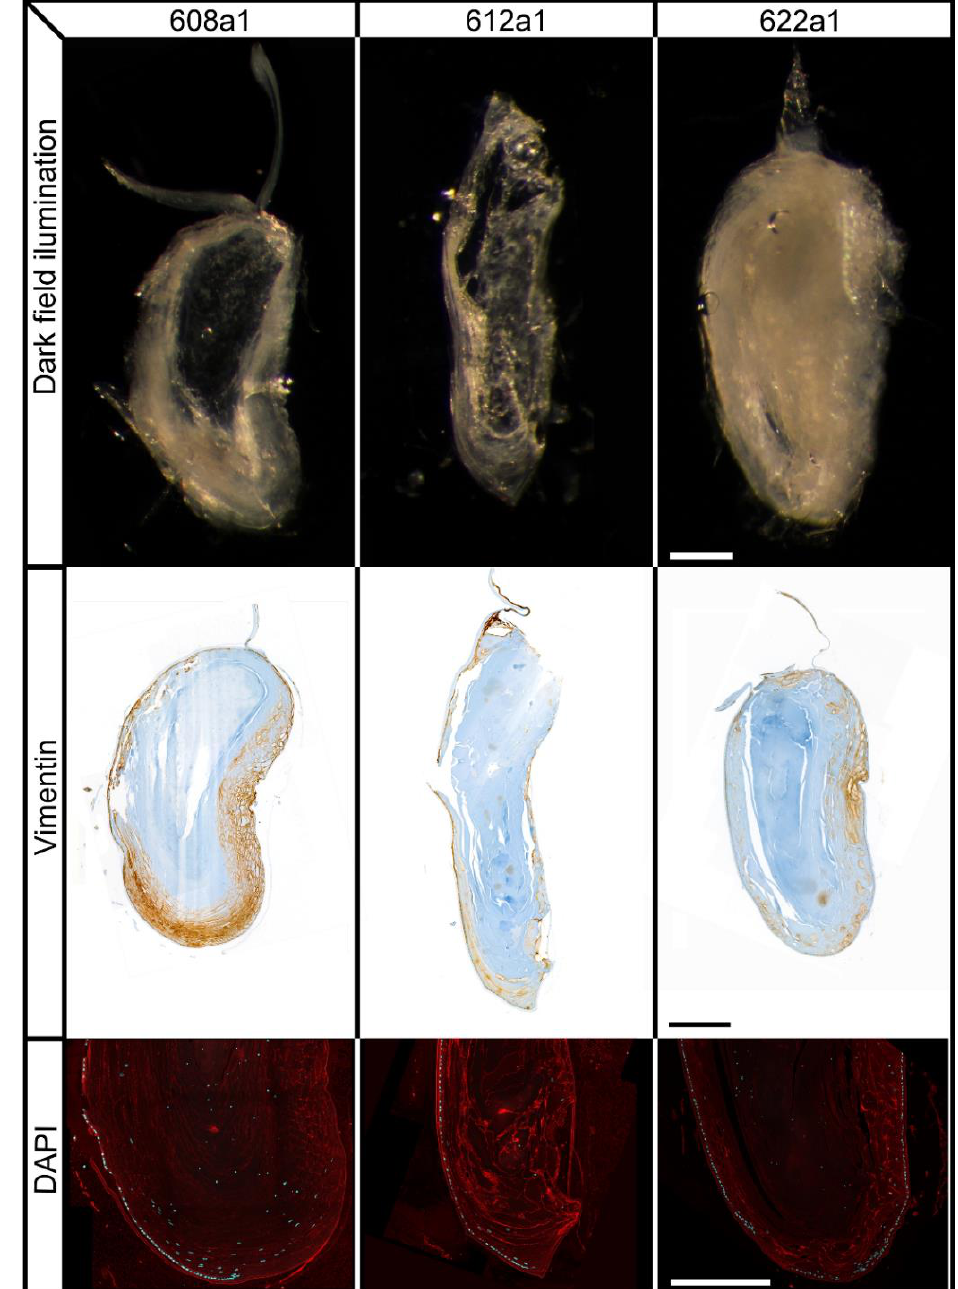
Figure 5. Images of 3 samples representative of our results. Cross-section dark field illumination images show different transparency/opacity distributions. Vimentin immunostaining highlights areas of developing fiber cells. DAPI highlights the distribution and size of cell nuclei in the epithelium at the lens bow and towards the center. Scale bars = 300 µm .